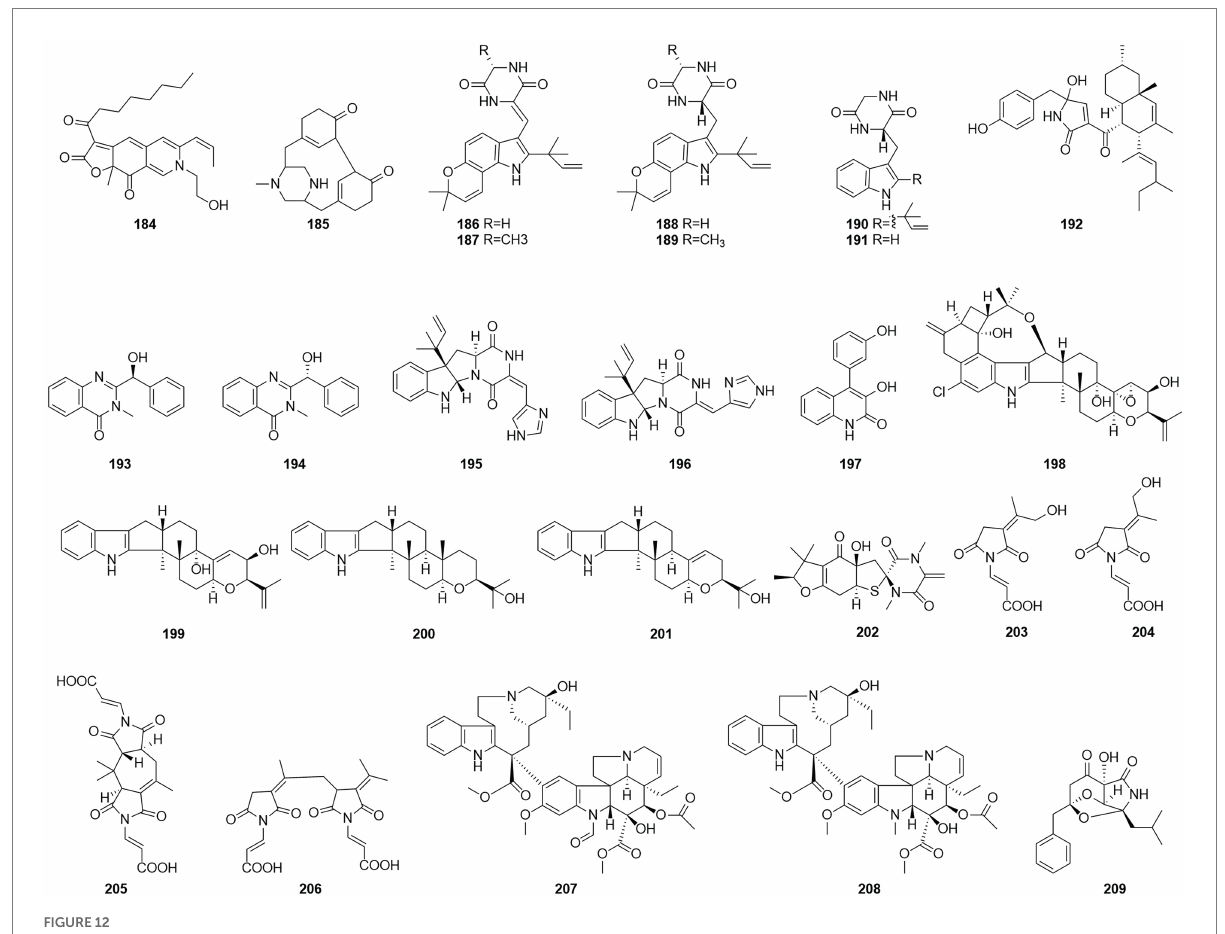
FIGURE 12 Chemical structures of compounds 184–209